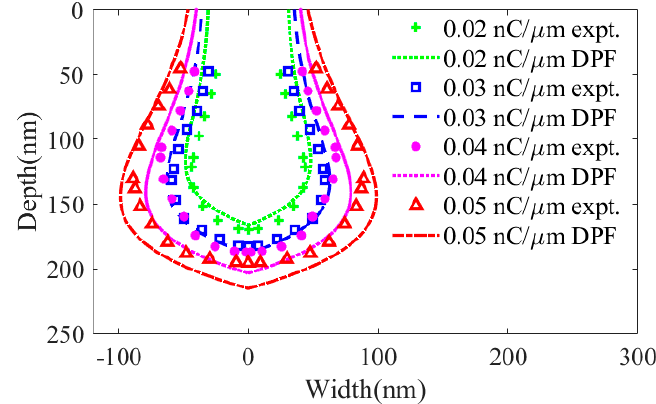
Figure 11. Experiments and DPF calculations of the amorphous damage profile of silicon substrate treated with He-FIB at a beam energy of 15 keV with ion doses of 0.02, 0.03, 0.04 and 0.05 nC/ μ m. width has an approximately linear increase, and its maximum calculated error does not exceed 20